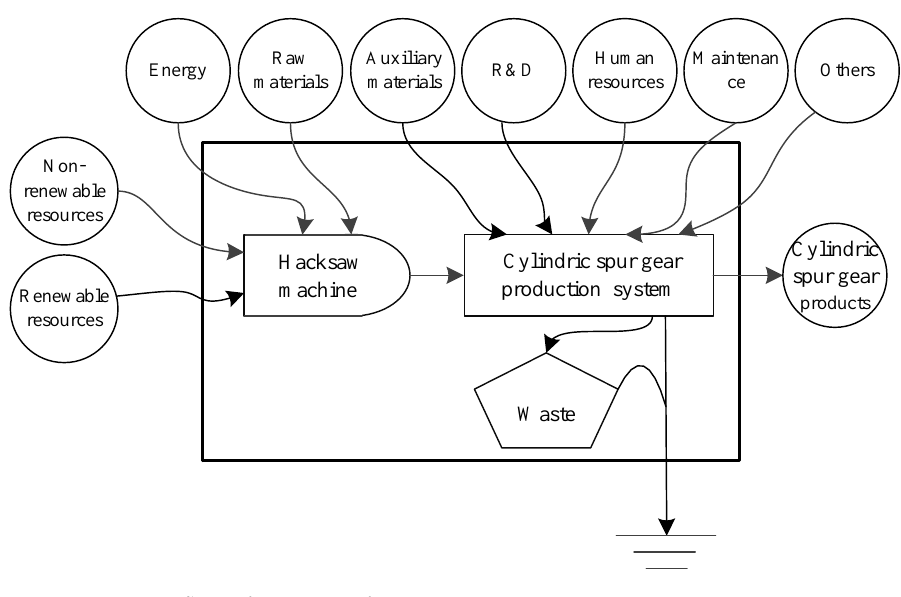
Figure 1. Emergy flow of gear manufacturing.